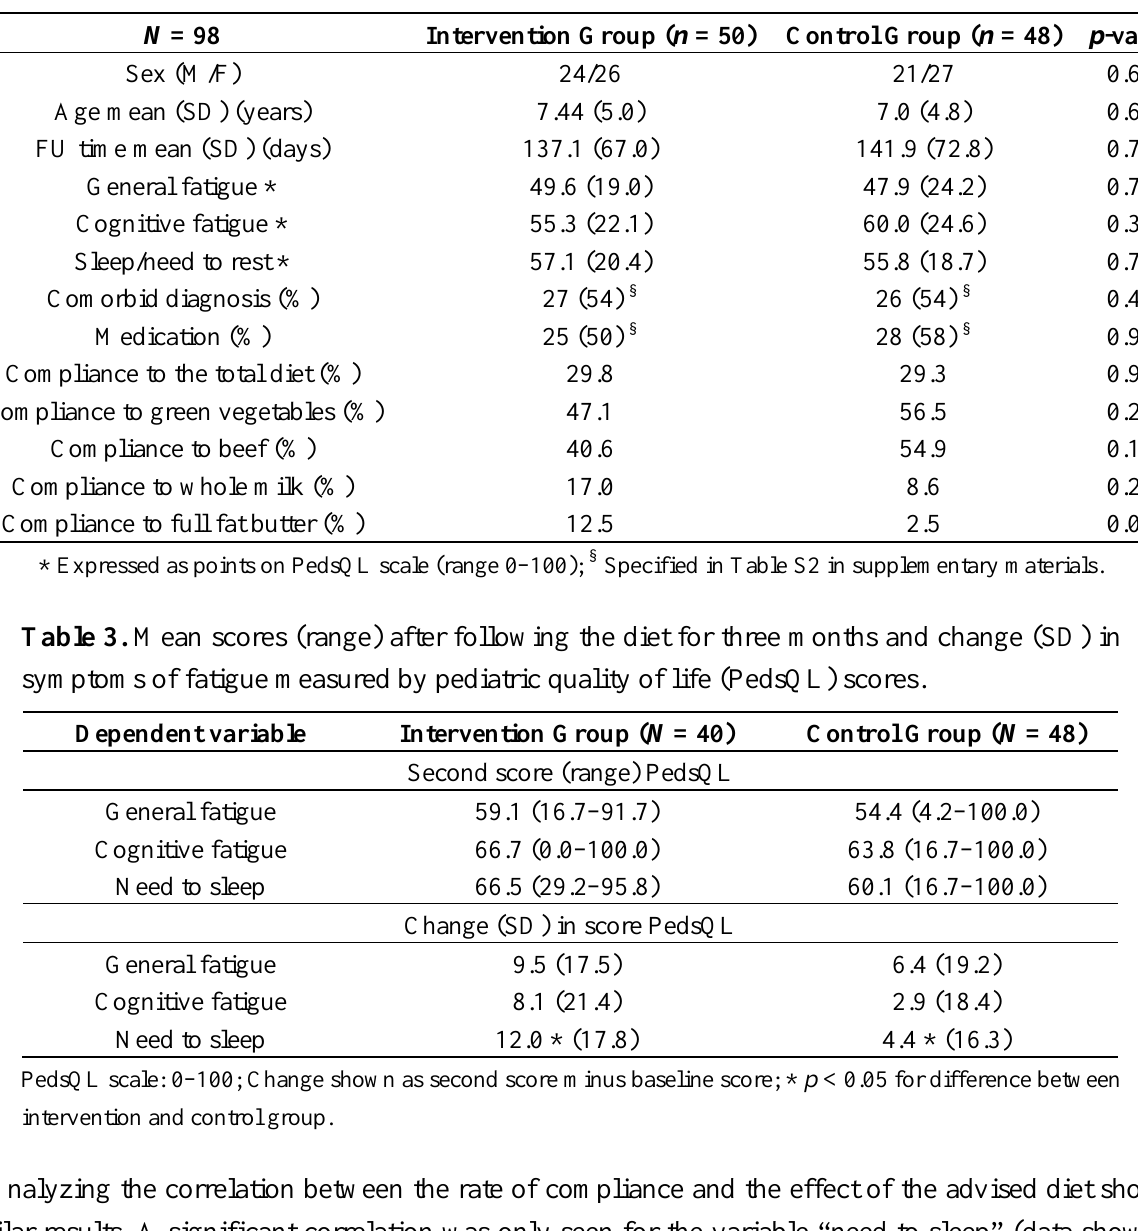
Table 2. Demographic characteristics baseline.